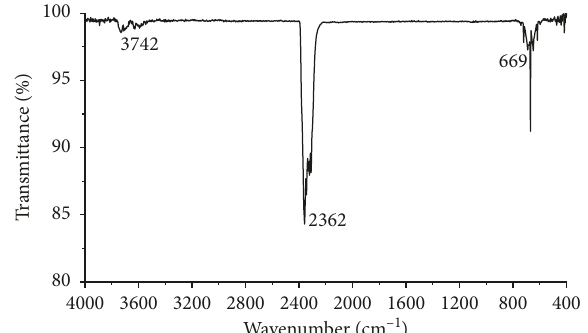
Figure 8: Infrared spectra of gaseous volatiles in the third com- bustion stage of